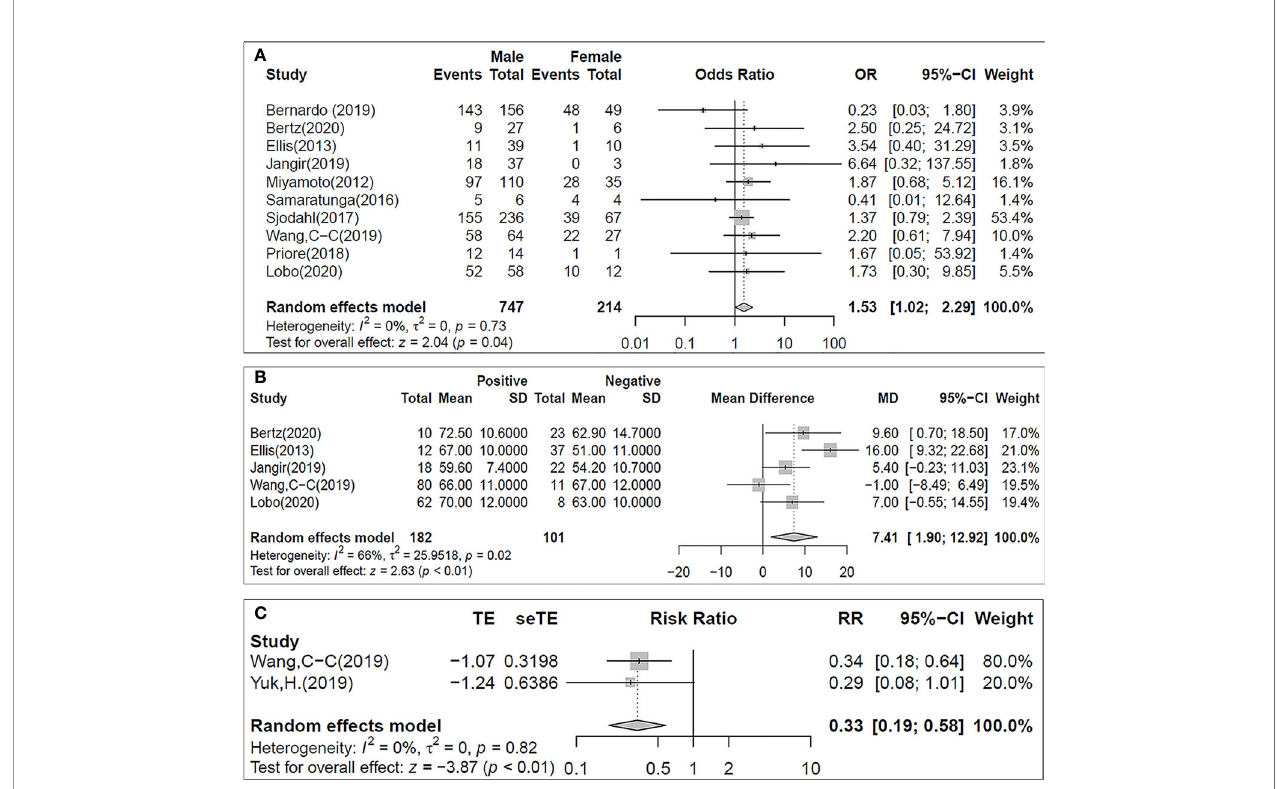
FIGURE 5 | Forest plots for the binary meta-analysis stablishing the association between GATA3 positivity and the patients ’ sex (A) , age at the time of surgery (B) and the recurrence free survival [RFS; (C) ]. Individual study estimates of crude odds ratios (OR) and 95% con fi dence intervals (CI). The diamond at the bottom of the plot denotes the random effects estimate. Error bars indicate con fi dence intervals. Heterogeneity